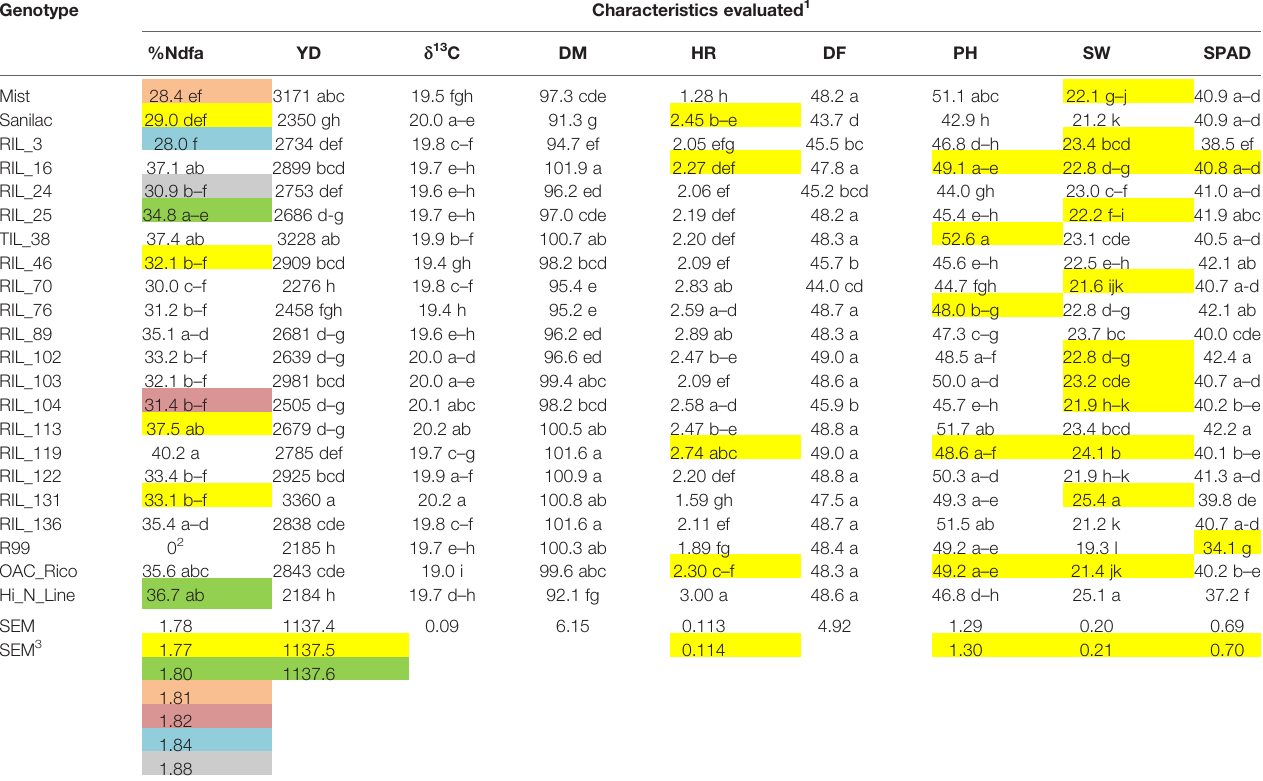
TABLE 7 | Performance of 22 common bean genotypes evaluated at the Elora research station, ON in 2017 and 2018. Genotype